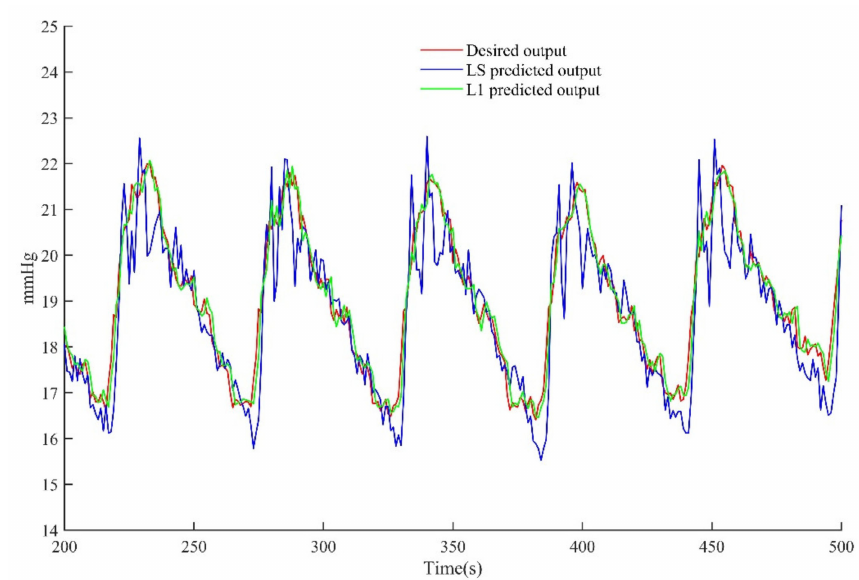
Figure 7. The system output waveforms. The waveform depicted by the red curve is the desired system output, the blue curve depicts the predicted results by LS-ARX, and the green curve depicts the predicted results by L1-ARX. For the convenience of display, we only draw the prediction results for a certain period of